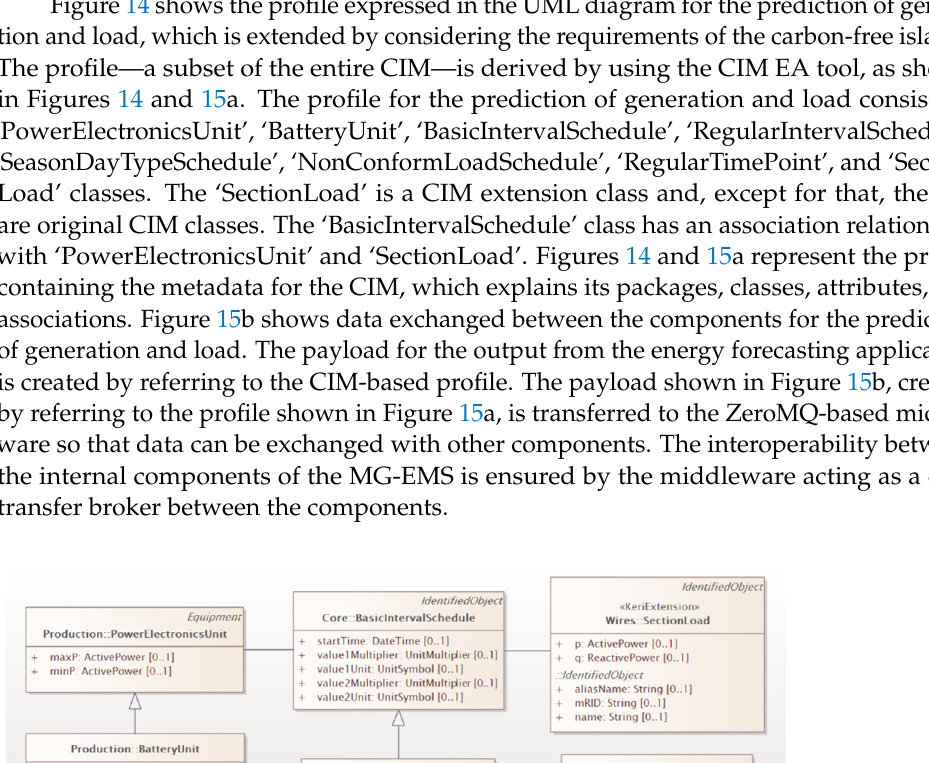
( b ) Figure 15. ( a ) Profile of the prediction of generation and load; ( b ) Payload of the prediction of generation and load. 5.2. Scenario 2: Service Restoration Figure 16 shows the profile expressed in the UML diagram for the service restoration plan using the ESS, which is extended by considering the requirements of the carbon-free islands. The profile is derived by using the CIM EA tool, as shown in Figures 16 and 17a. Figure 17a,b show the profile and payload used for data exchange to operate the service restoration application, respectively. The profile for the service restoration plan using the ESS consists of ‘Restoration’, ‘RestorationFuzzy’, ‘SectionGroup’, ‘Section’, ‘SectionLoad’, ‘Fuzzy’, ‘MembershipFunction’, ‘Fault’, ‘RestorationType’, ‘ACLineSegment’, and ‘BatteryUnit’ classes. The ‘ACLineSegment’ and ‘BatteryUnit’ are original CIM classes, while the ‘Restoration’, ‘RestorationFuzzy’, ‘SectionGroup’, ‘Section’, ‘SectionLoad’,